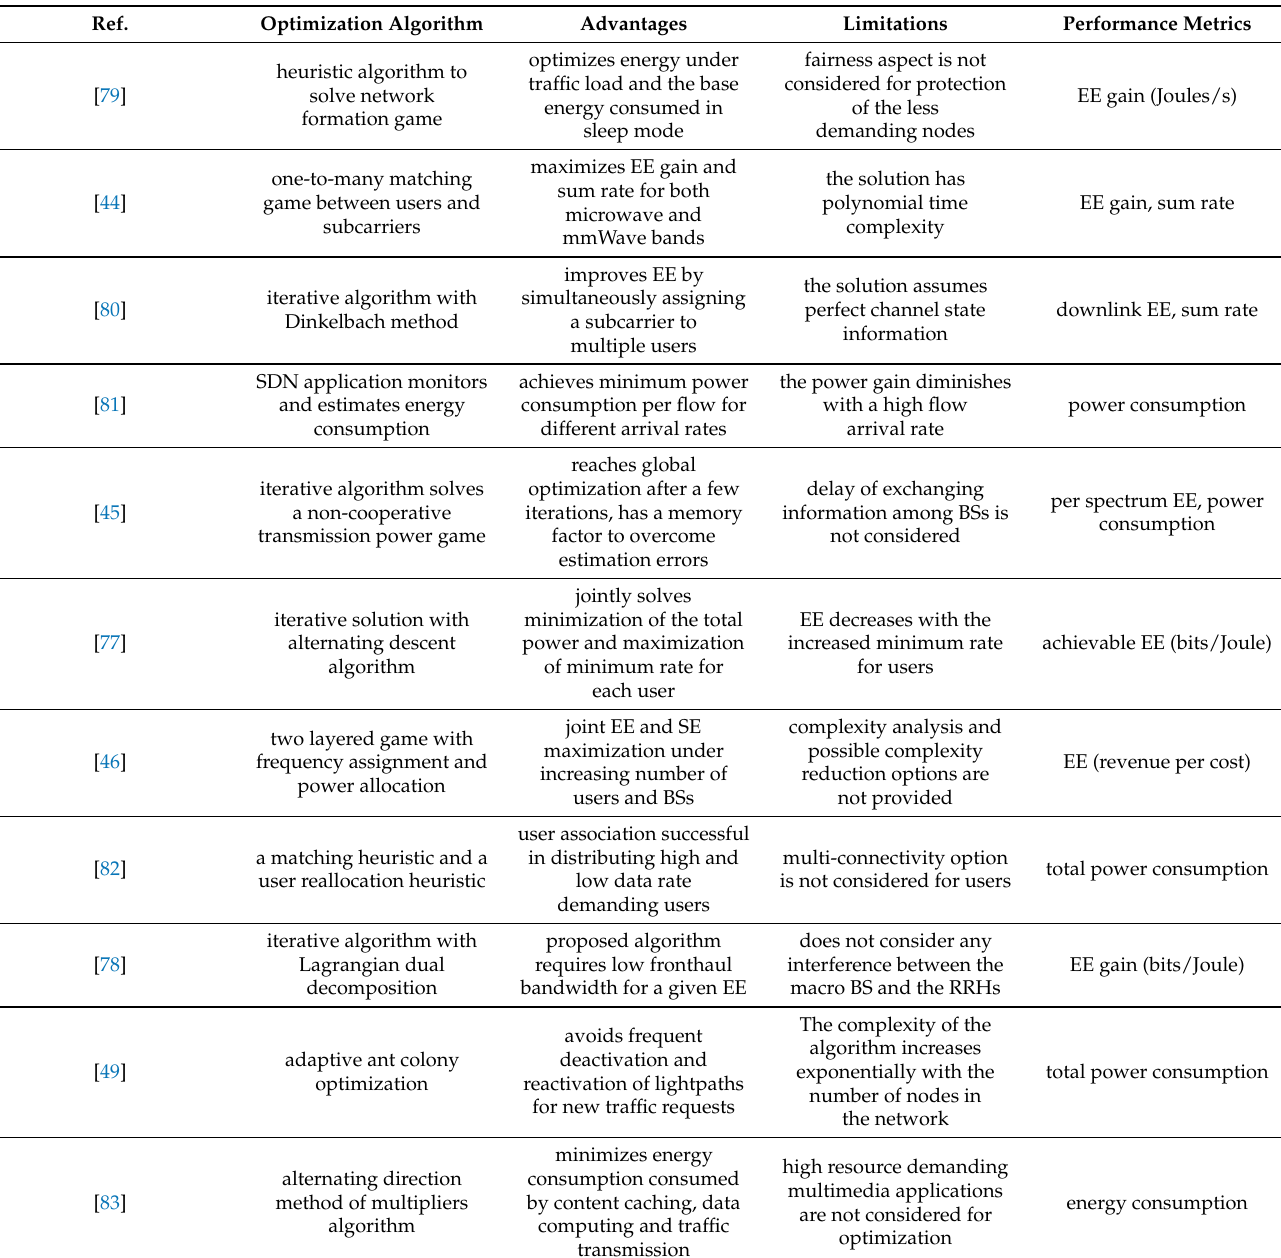
Table 5. Analysis of resource allocation papers with energy-efficiency objective.